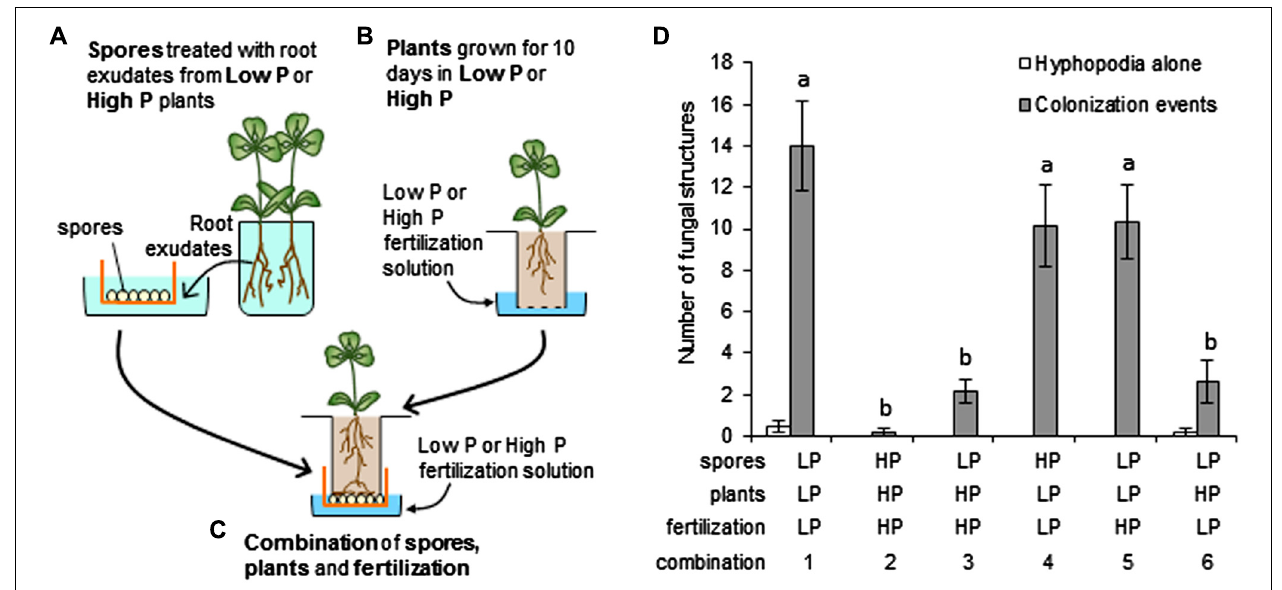
whole root systems of each plant. Root zones displaying hyphopodia alone (open bars) or colonization events (closed bars) were counted. Colonization events corresponded to zones where AM fungi had formed a hyphopodium and penetrated the root (with or without formation of arbuscules). Several combinations of low P (LP) and high P (HP) applied to spores, recipient plants and fertilization during contact were tested (numbered from 1 to 6). Error bars represent the SEM. n = 6 plants per combination. Numbers of colonization events were compared across combinations using one-way ANOVA followed by Fisher’s LSD test. Normality of residues was verified using the Kolmogorov–Smirnov’s test. Different letters indicate statistically significant differences ( P <